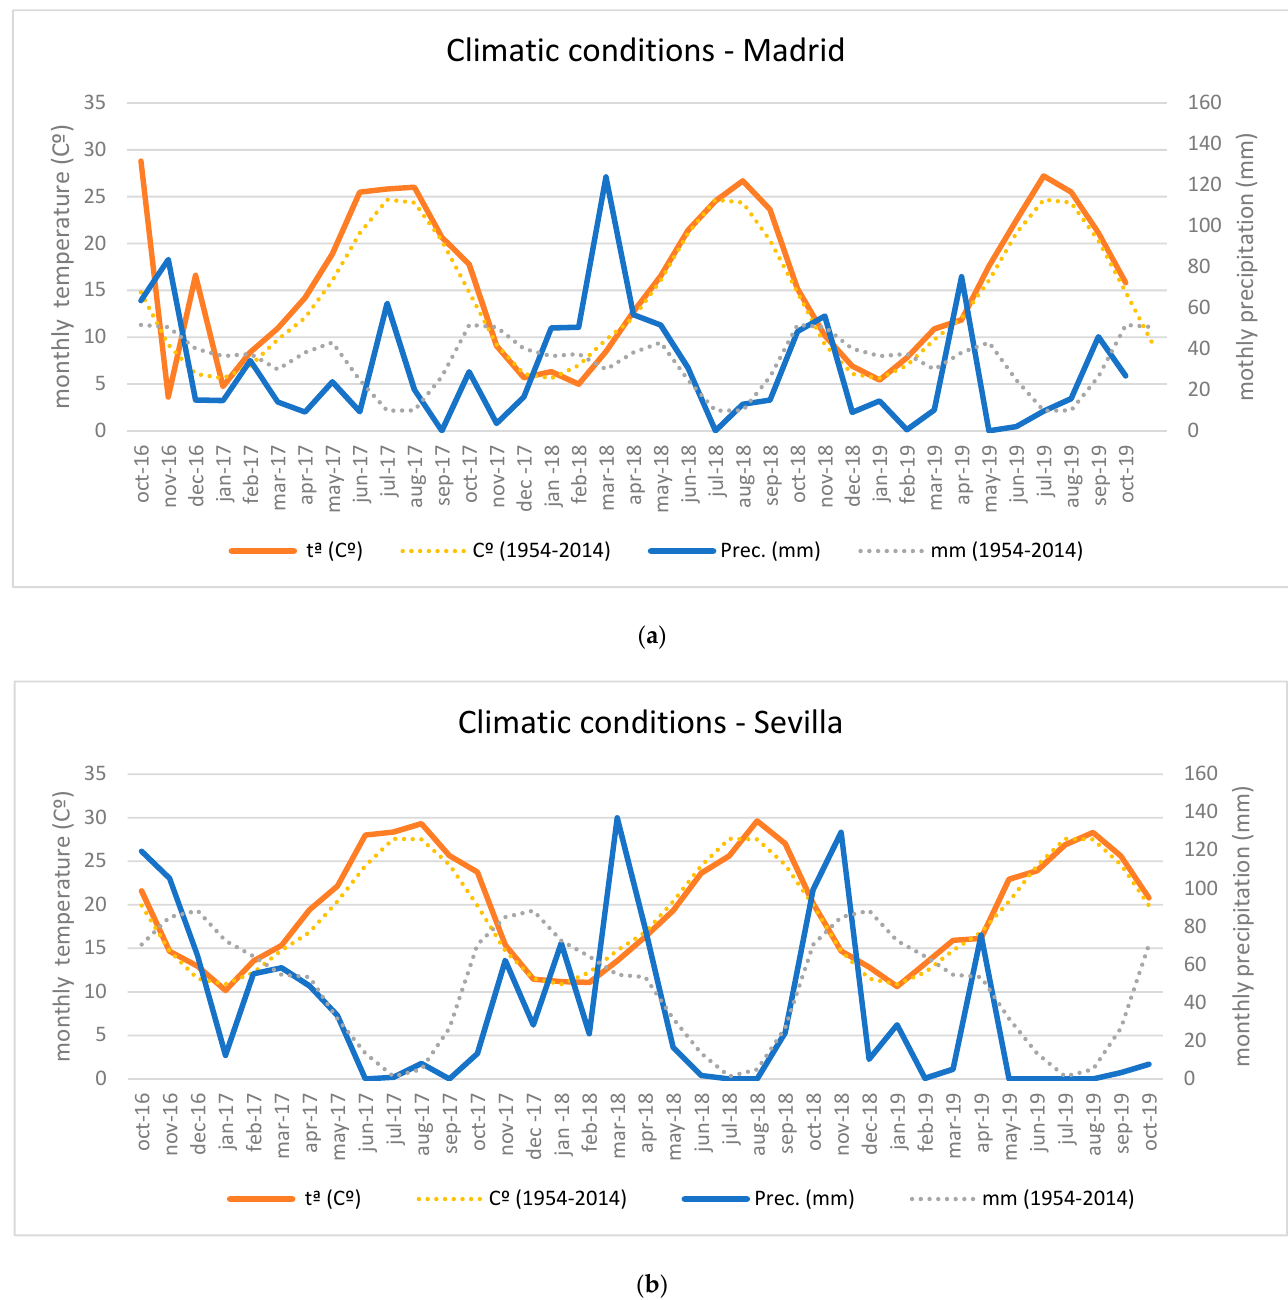
Figure 1. Climatic conditions 2017–2019 (average monthly precipitation and temperature and his- torical mean in: ( a ) Madrid; M and ( b ) Sevilla; S. Average monthly temperature (tª—in orange) and precipitation (Prec. -in blue) during 2017–2019 in M and S sites. In point lines, the historical mean of temperature (C°-in yellow) and precipitation (mm-in grey) for both locations.